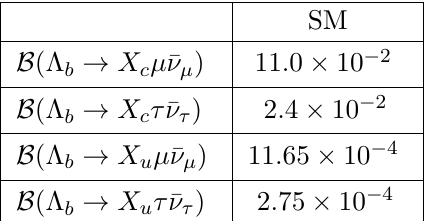
Table 1 . Inclusive semileptonic (cid:3) b branching fractions in SM, obtained for the central values of the